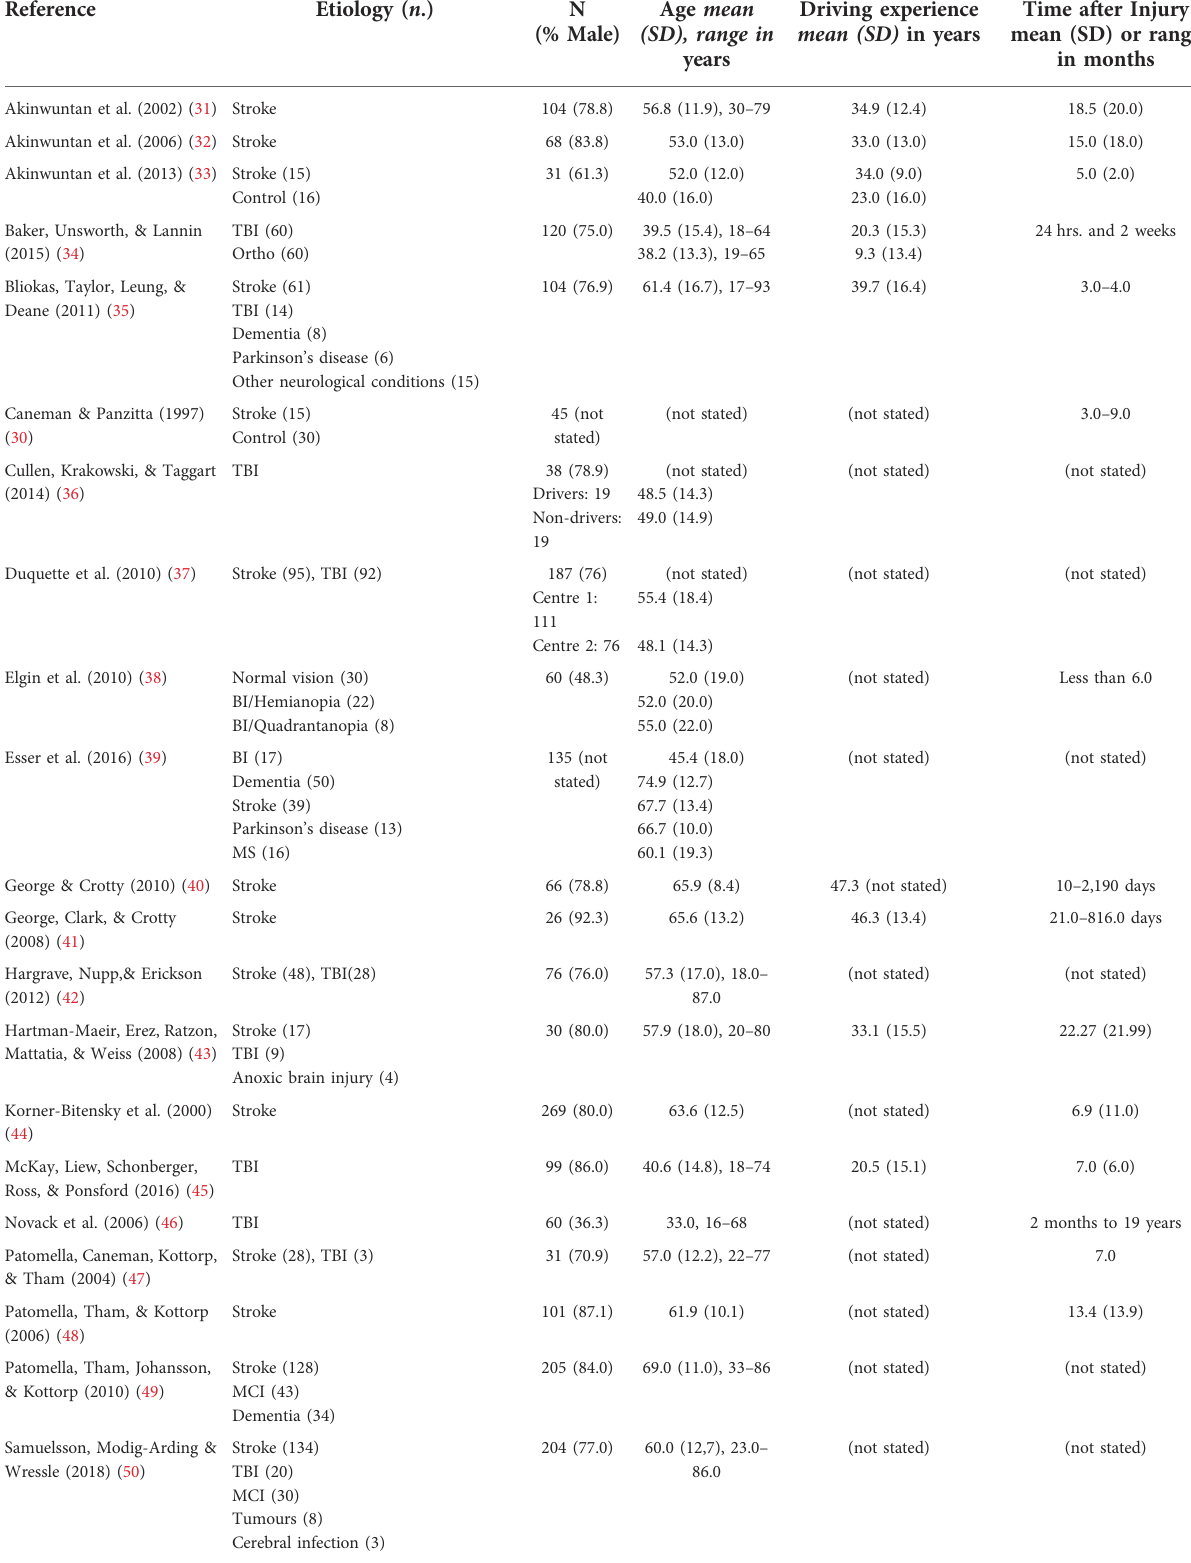
TABLE 1 Participant ’ s